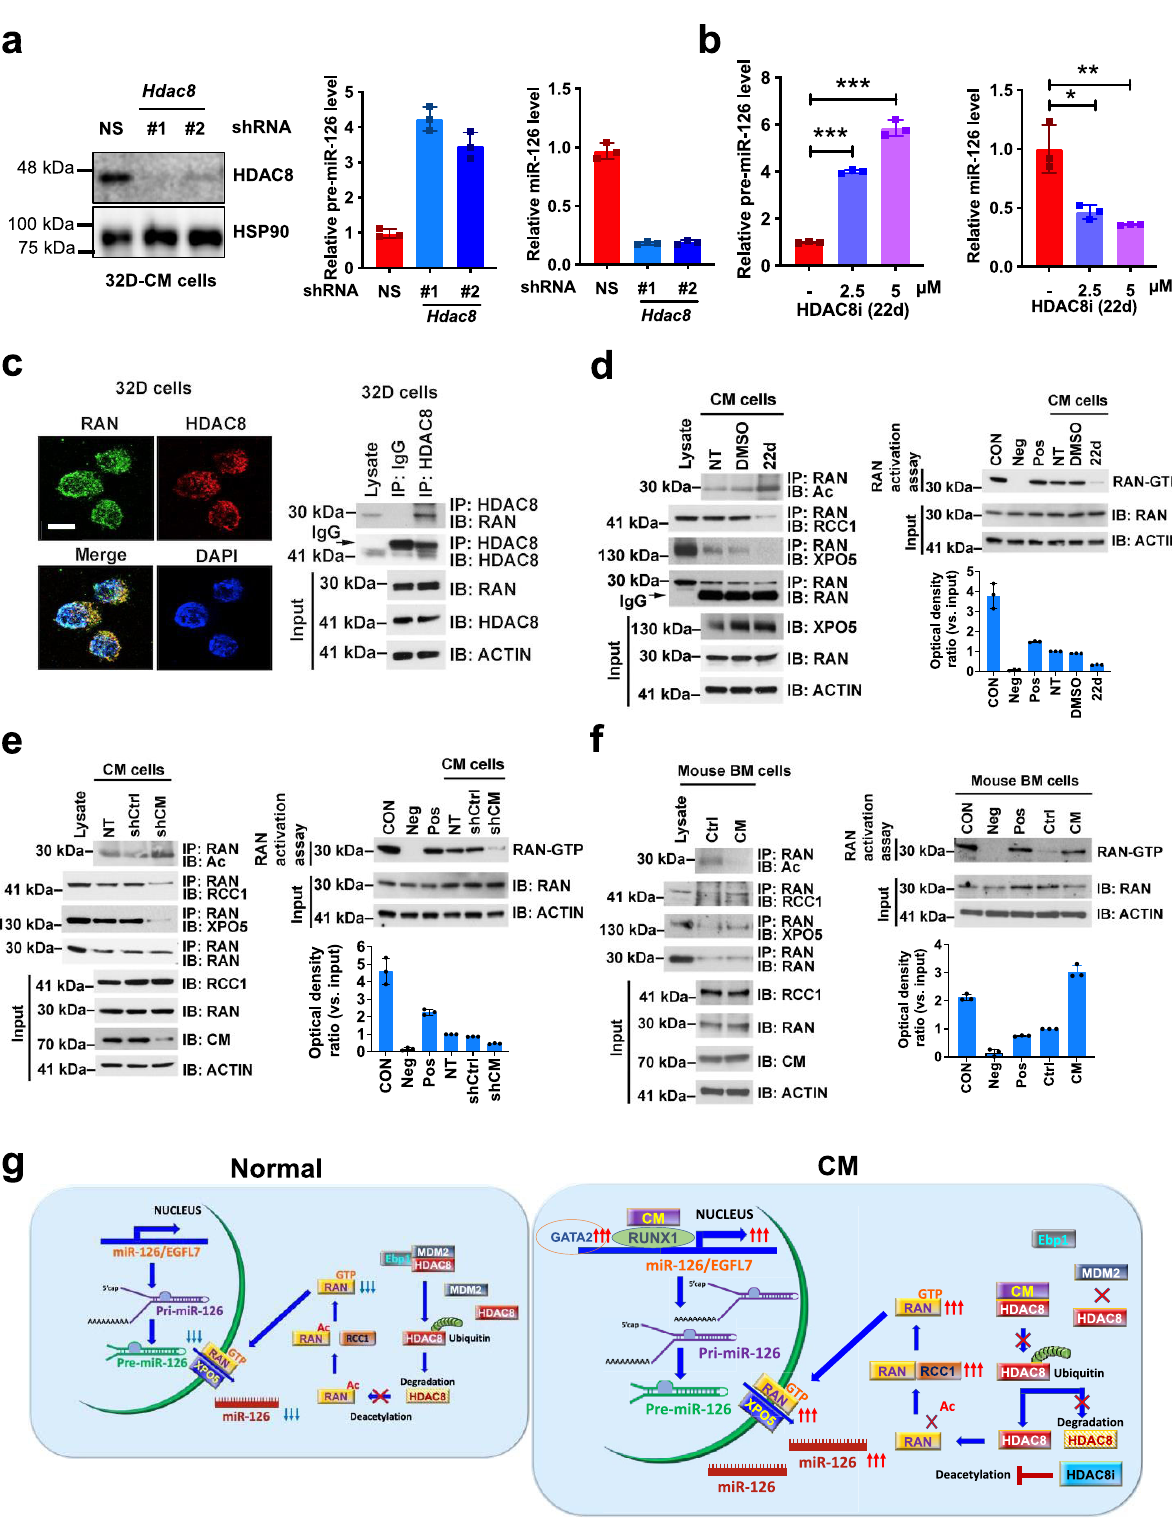
SPRED1 and PLK2 (polo-like kinase 2) are previously reported miR-126 targets 21,23,25,51 and negative regulators of RAS – MEK – ERK signaling 52,53 , which regulates MYC protein stability by phosphorylation of S62 54 . We veri fi ed that both Spred1 and Plk2 mRNA and protein levels are downregulated in CM LSK and upregulated in CM/miR-126 Δ / Δ LSK cells (Fig. 4a, b). Consistent with downregulation of Spred1 and Plk2 , CM LSK